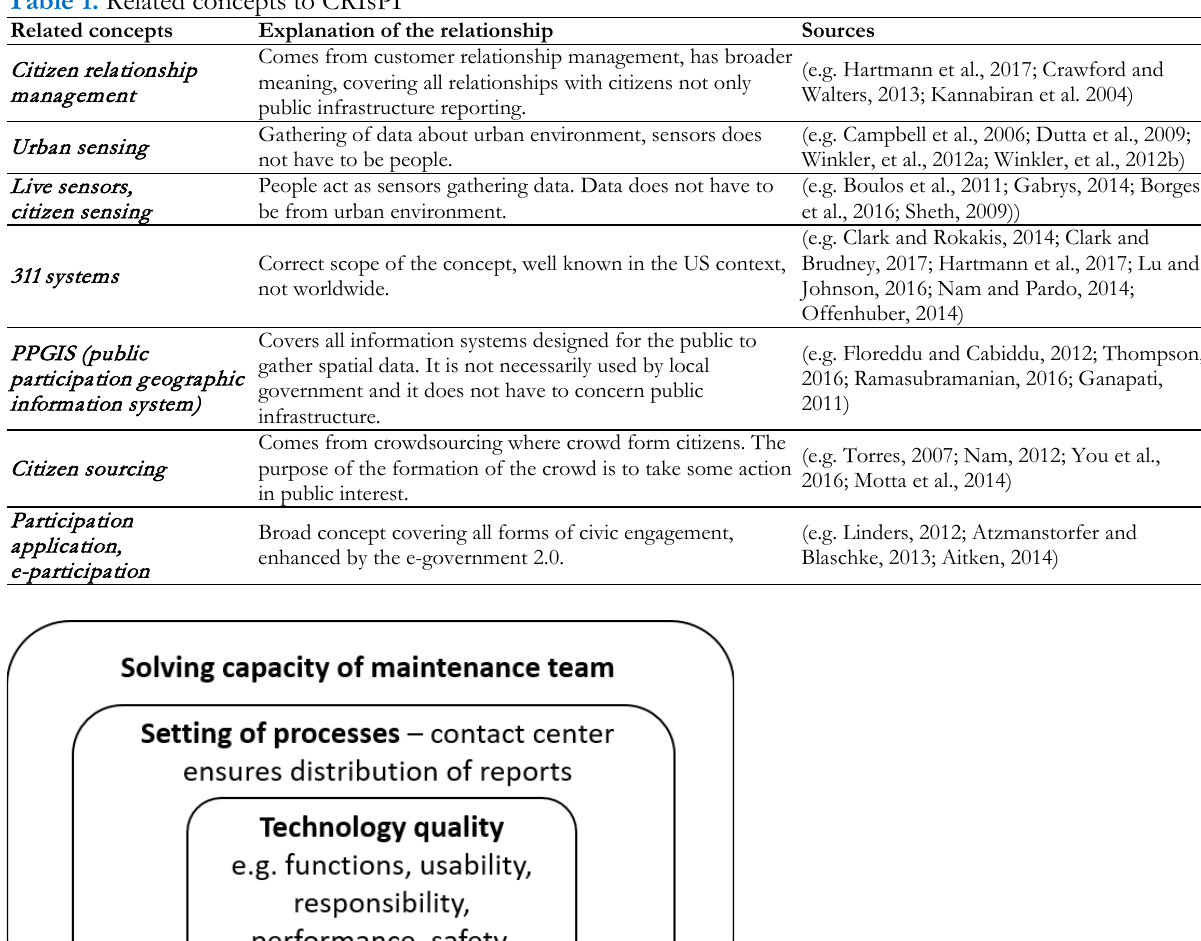
Table 1. Related concepts to CRIsPI